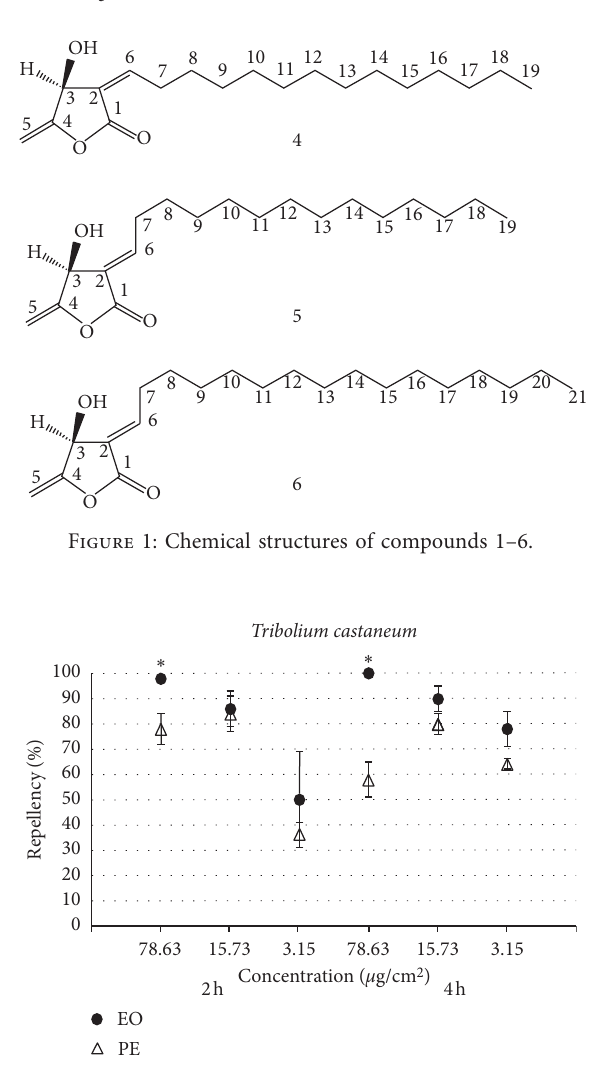
Figure 2: Percentage repellency (PR) of EO and PE from the C. camphora stem bark against T. castaneum at 2 and 4 h after ex- posure. ∗ Differences between PR values of EO and PE at the same concentration were determined by t -test ( ∗ P < 0 . 05) (EO: essential oil; PE: petroleum ether/EtOAc